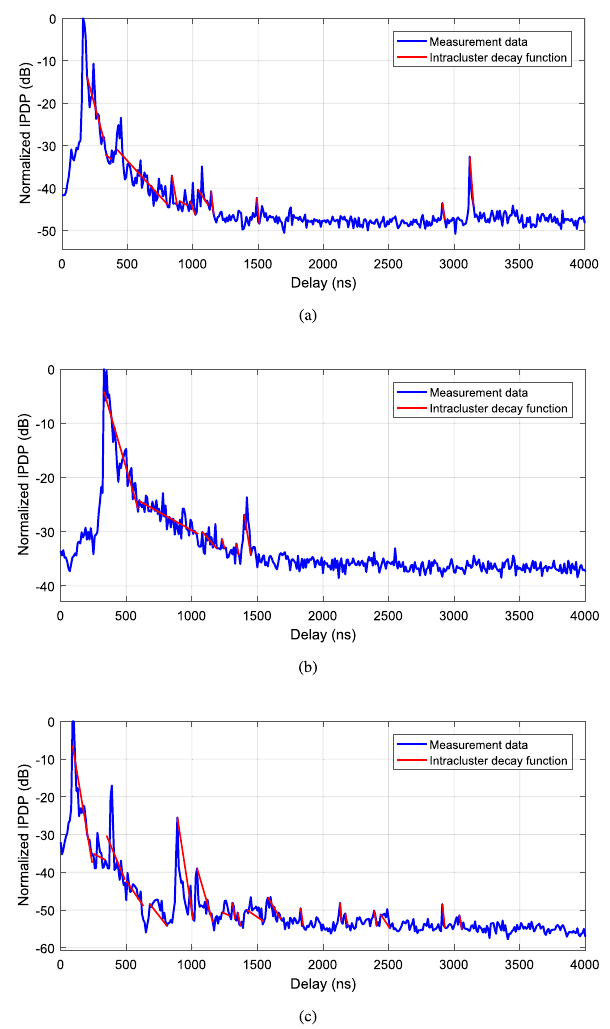
Figure 6. Result of cluster identification for the measurements. ( a ) Iron bridge. ( b ) Soundproof wall. ( c ) Roadside